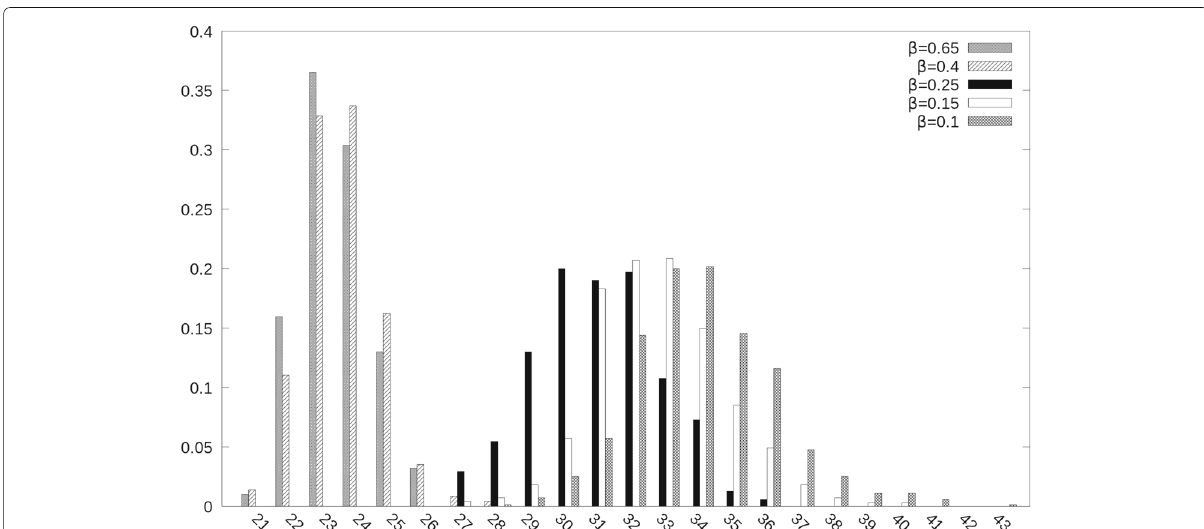
Fig. 7 Distribution of the number of roles in Domino (x axis) after incorporating 6 exceptions in all possible orderings